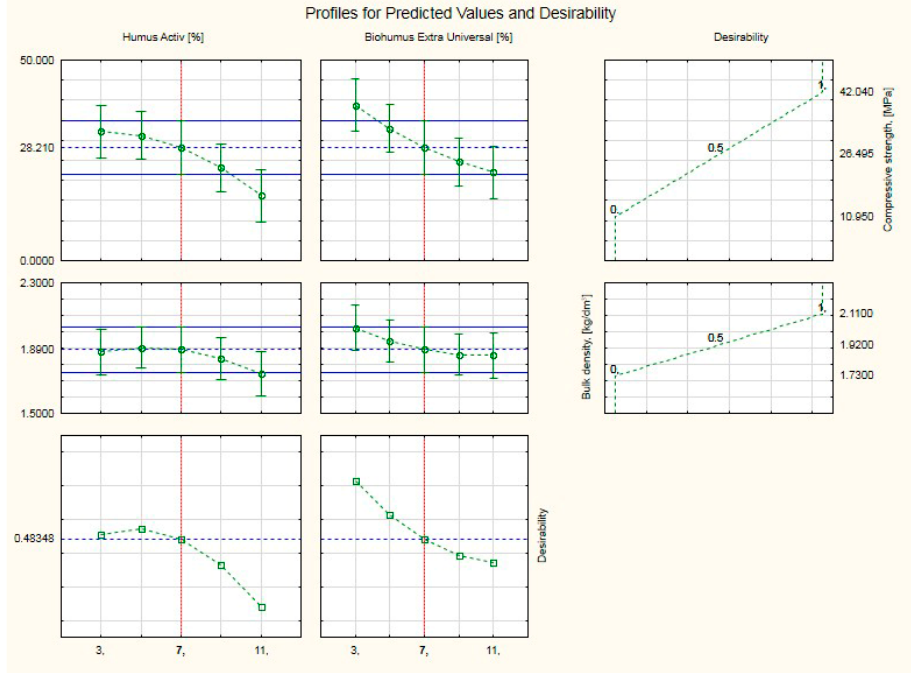
Figure 19. Profiles of predicted values and desirability. Profile of overall usability (compressive strength and bulk density) of silicate products with Humus Activ and Biohumus Extra Universal, for average values.